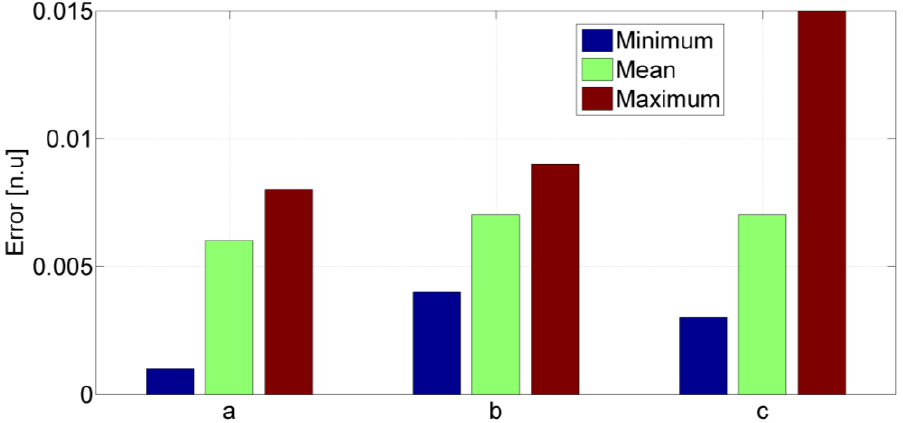
Figure 9. Minimum, mean and maximum absolute differences between ―fitted‖ and ―universal‖ parameters of the proposed step length model.